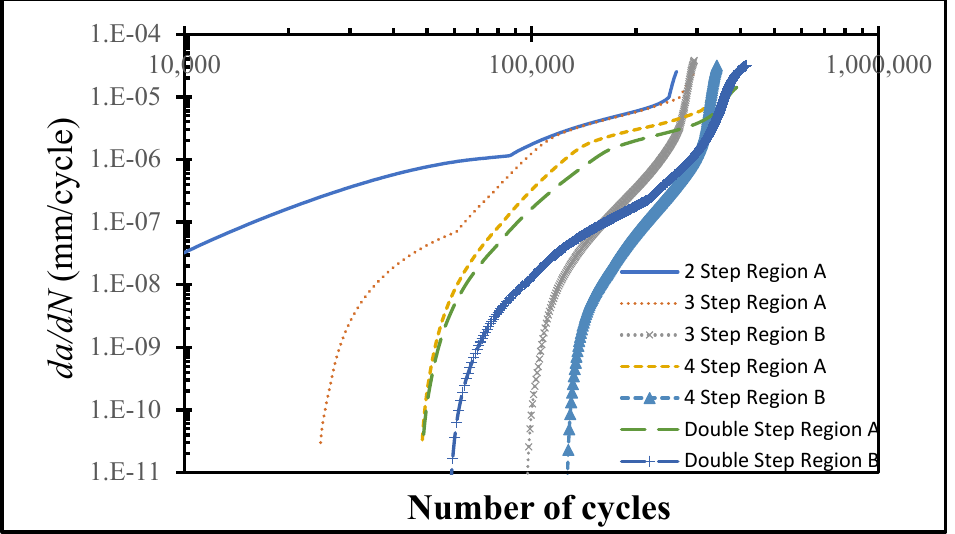
Figure 7. da / dN vs. the number of cycles at different parts of the adhesive layer of various lap joints with different step configurations and subjected to 8.0 kN cyclic tensile load.